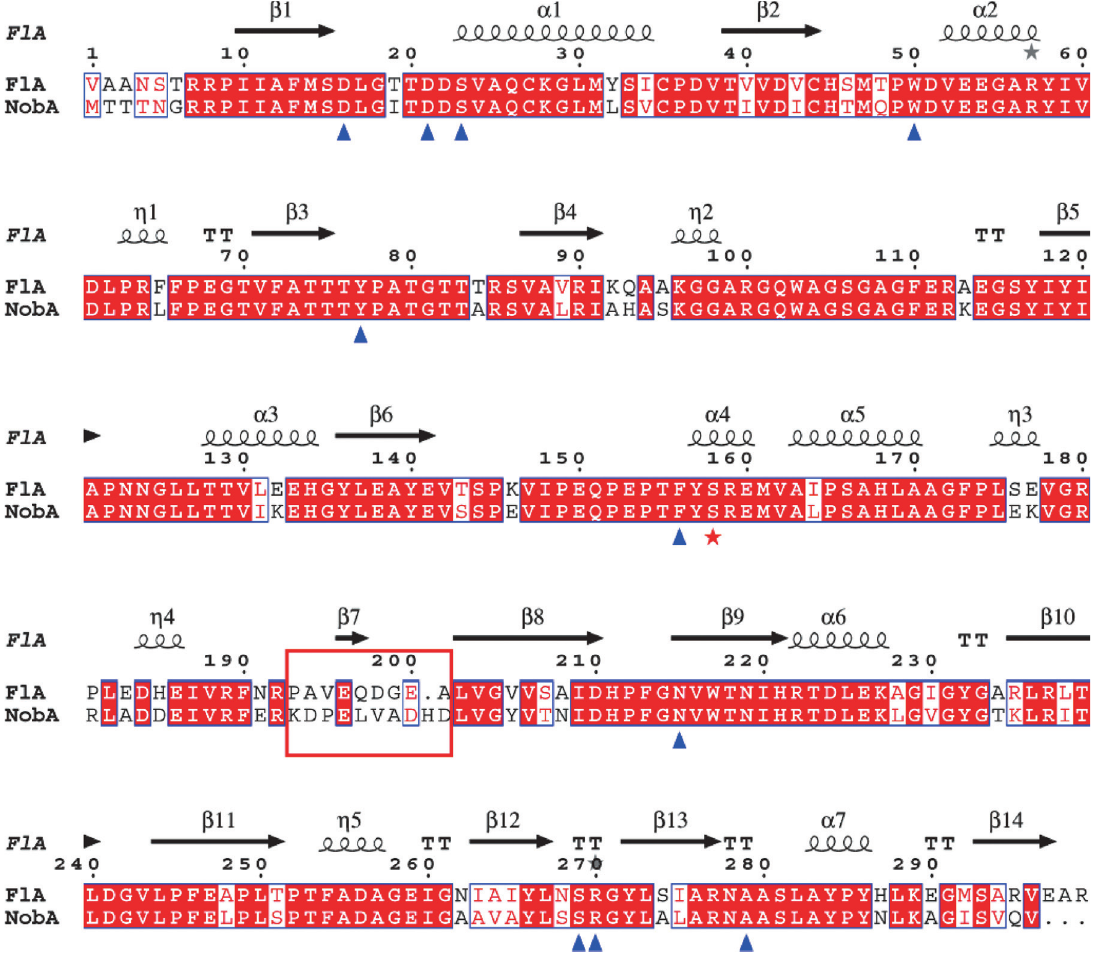
Figure S2. Sequence comparison between FlA and NobA. The secondary structure of FlA (PDB No. 2V7V) is shown on the top. Critical residues (D16, D21, S23, W50, Y77, F156, N215, S269, R270 and A279) for SAM and fluoride binding are labeled by blue triangle). Residue S158 for fluoride desolvation is labeled by red pentagram. The distinct loop region (R192-L202, FlA numbering) which is bracketed by rectangle.